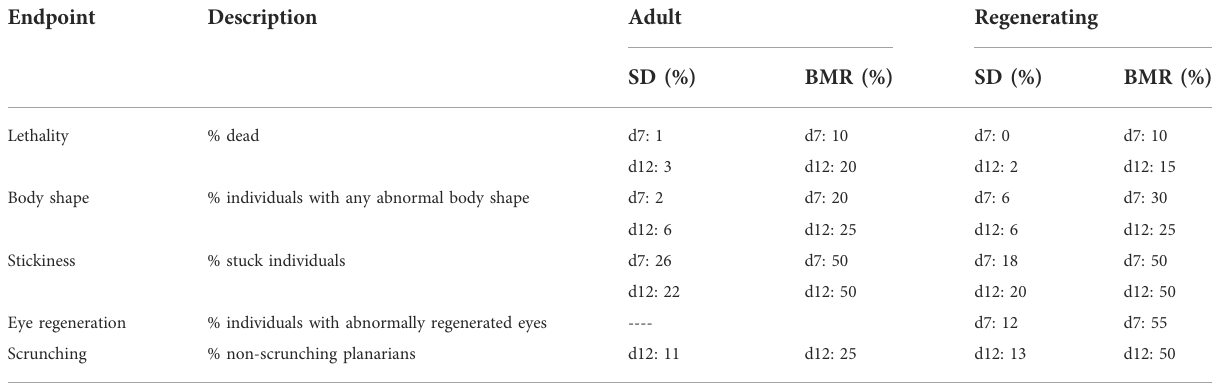
TABLE2Binaryendpoints.Thestandarddeviation(SD)ofthevehiclecontrolsandbenchmarkresponse(BMR)arecomparedforeachendpointonday 7 (d7) and day 12 (d12), except for eye regeneration and scrunching which were only evaluated on d7 and d12,